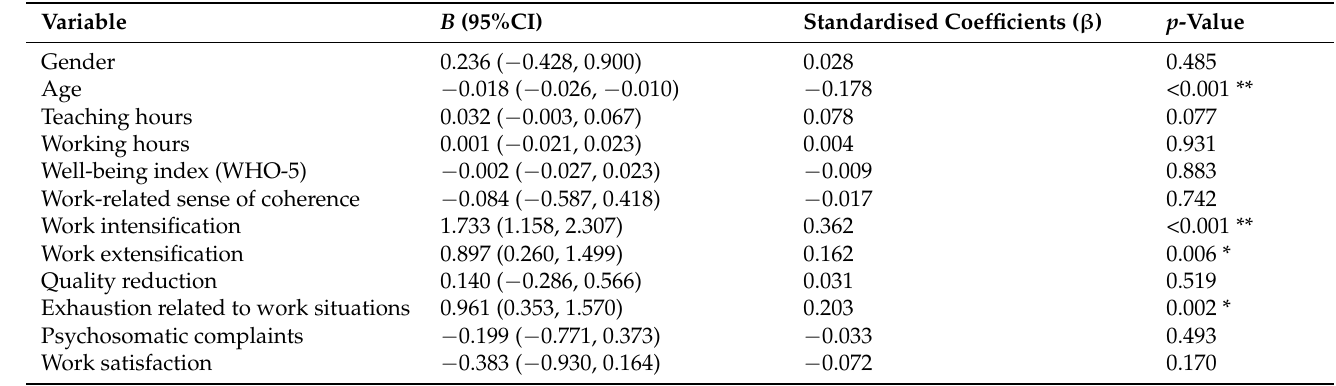
Table 6. Regression model for predicting teachers’ level of perceived